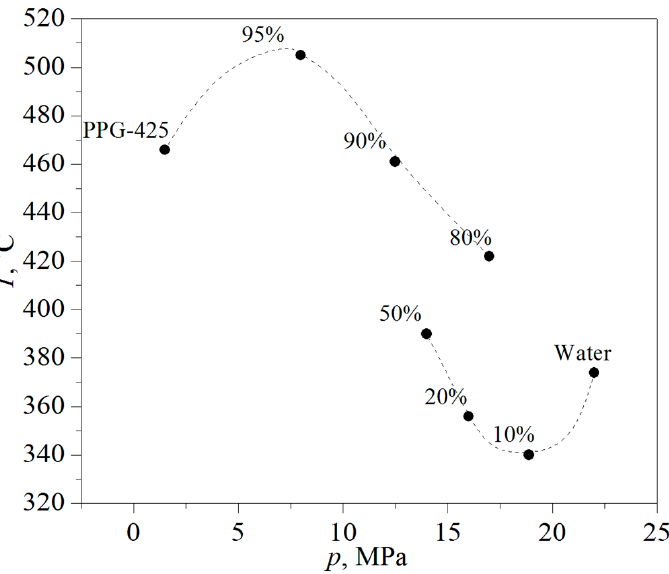
Figure 5. Approximation of the water/PPG-425 mixture’s liquid–vapour critical curve. The percent- ages above the experimental points indicate the mass content of PPG-425 in the mixture. Dashed lines are drawn by eye.